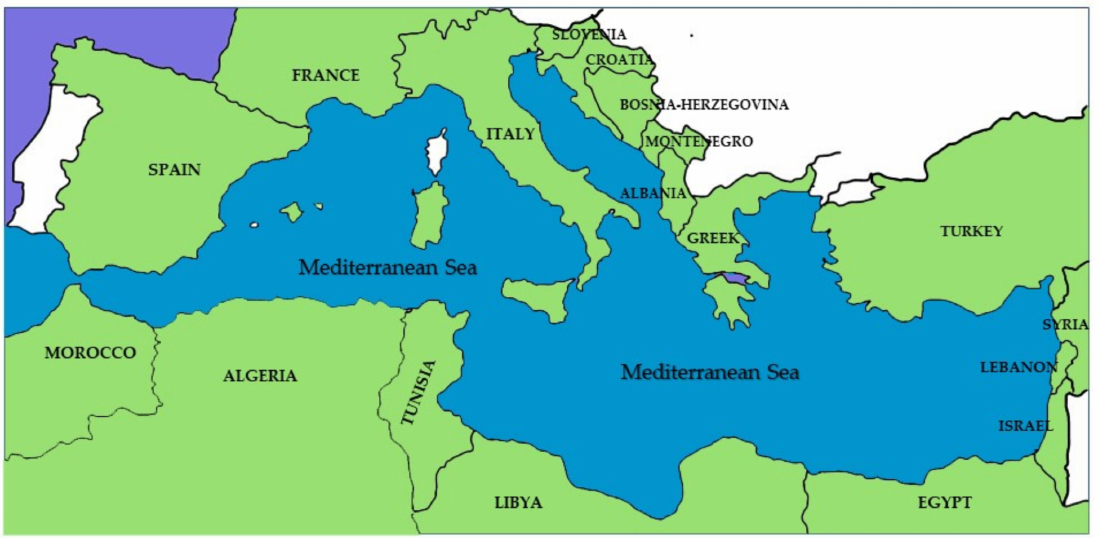
Figure 3. Mediterranean basin and its bordering countries.